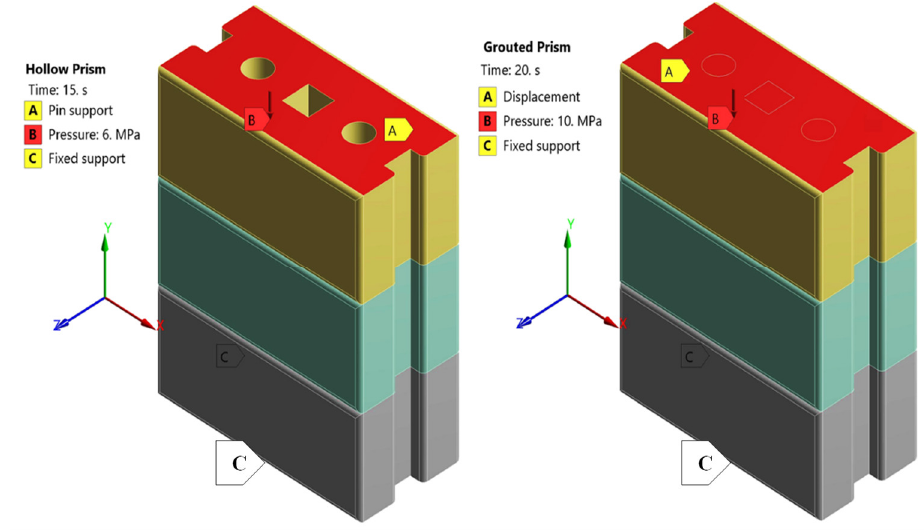
Figure 6. Load and boundary conditions of FE hollow and grouted prism.